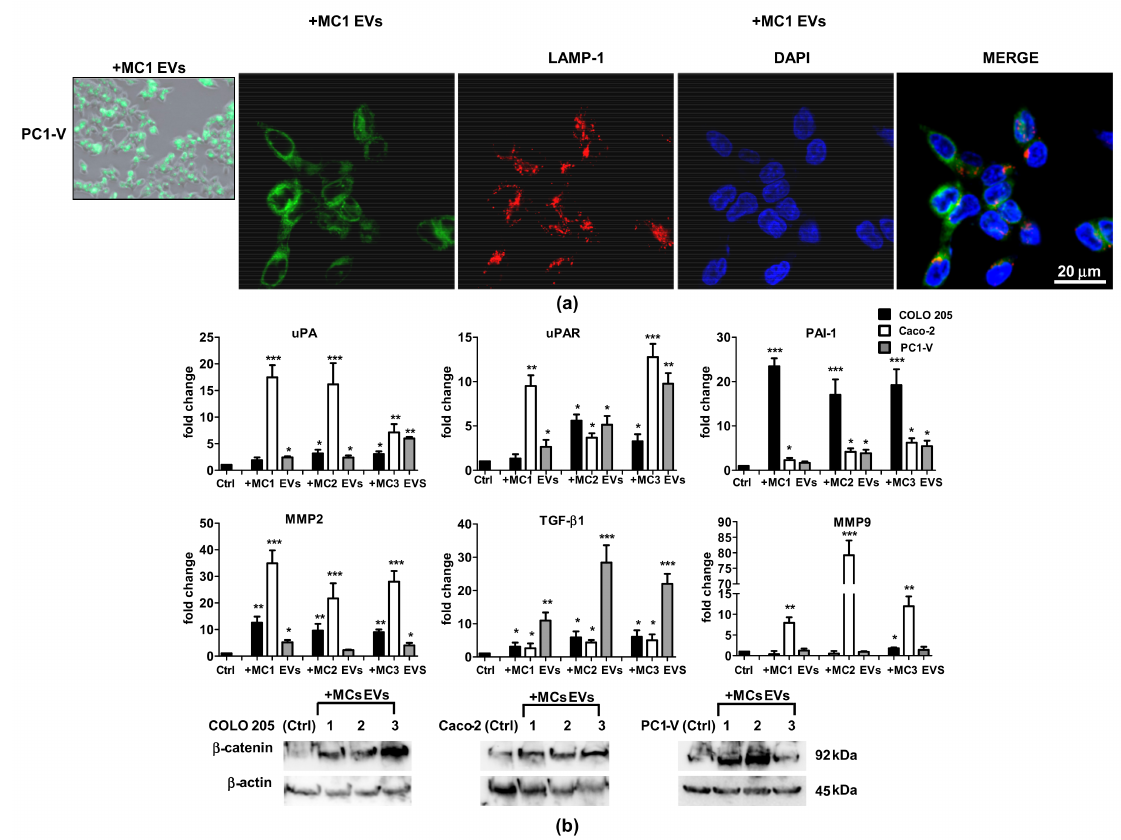
Figure 2. Uptake of MC EVs causes upregulation of metastatic signaling pathways in tumor cell lines. ( a ) Left side: Repre- sentative images showing the internalization of fluorescent PKH67- MC EVs (green) in the PC1-V cell line (magnification × 400). Right side: Representative images of fluorescence confocal microscopy showing PKH67-MC1 EV uptake and colocalization with LAMP-1 (red) in PC1-V cells (magnification × 1000). ( b ) Fold change of uPA, uPAR, PAI-1, MMP-2, MMP-9, and TGF- β 1 transcript levels in cancer cells after treatment with MC1-3 EVs. Each value reported in the histograms is the mean ± SD of three different experiments performed in triplicate (* p < 0.05, ** p < 0.01, and *** p < 0.001 relative to each untreated control). ( c ) Representative immunoblots showing β -catenin protein expression in COLO 205, Caco-2, and PC1-V treated with MC1-3 EVs. β -actin is used as loading